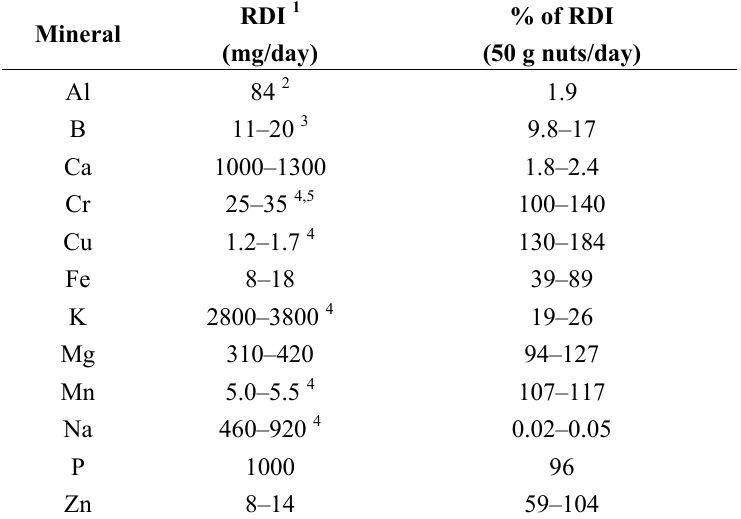
Table 4. Recommend daily intake (RDI) of minerals and percentage provided by the consumption of 50 g of New Zealand grown Italian stone pine ( Pinus pinea )